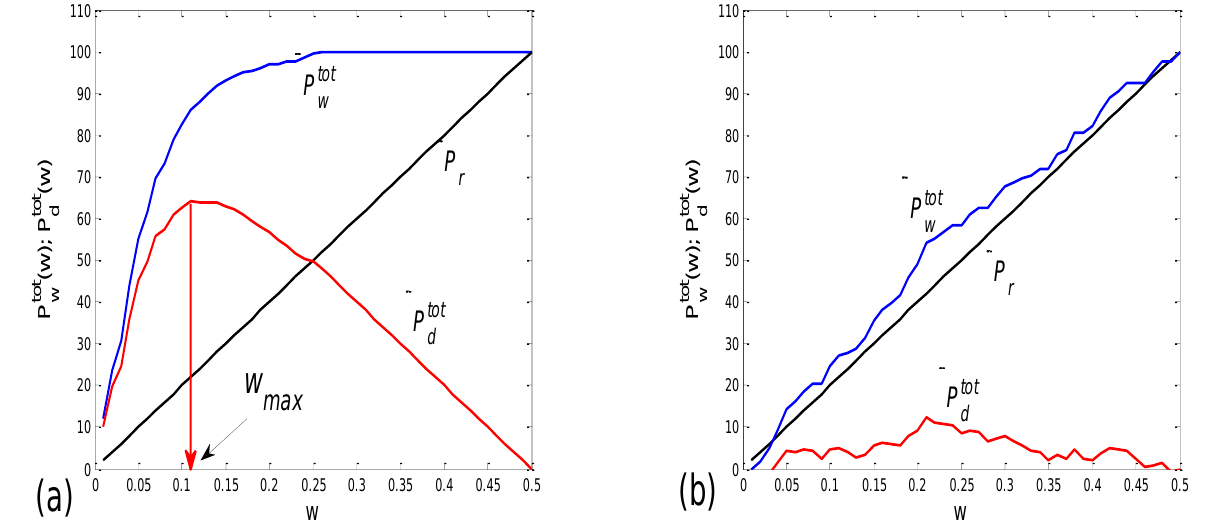
Figure 4. Example scatter plots: ( a ) with an aggregation of points around the concurrent PRQ int lines; ( b ) with a random distribution of points. P wtot — the percentage of points that lie within the gradually widening sectors, with a half-width of w , calculated for all clusters simultaneously, according to Equation (5); P r — the same quantity of uniformly distributed points; P dtot — their difference according to Equation (6); w max — the half-width where the maximum of P dtot occurs.